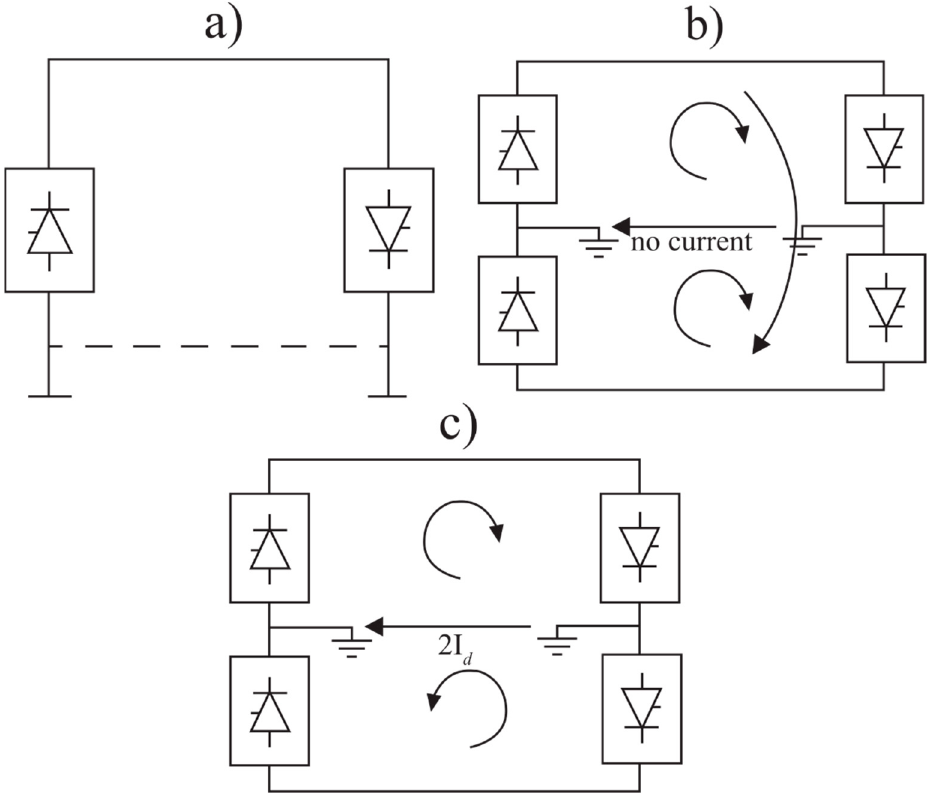
Figure 3. HVDC configurations: ( a ) Monopolar, ( b ) Bipolar, ( c ) Homopolar. Table 1. Different configurations for HVDC